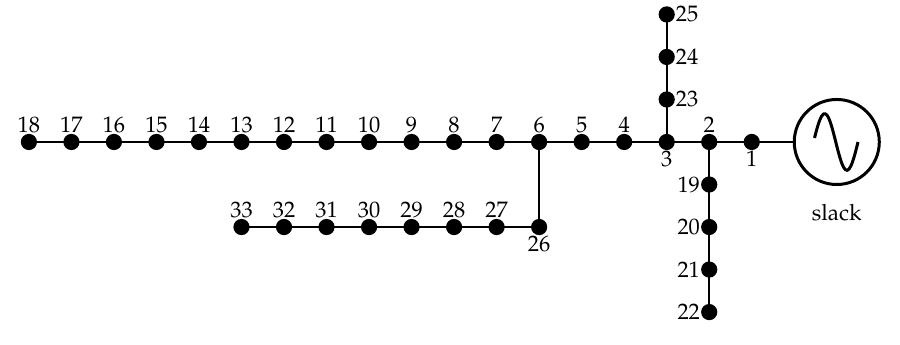
Figure 2. The 33-node test feeder topology. Table 1. Parametric information of the 33-node test